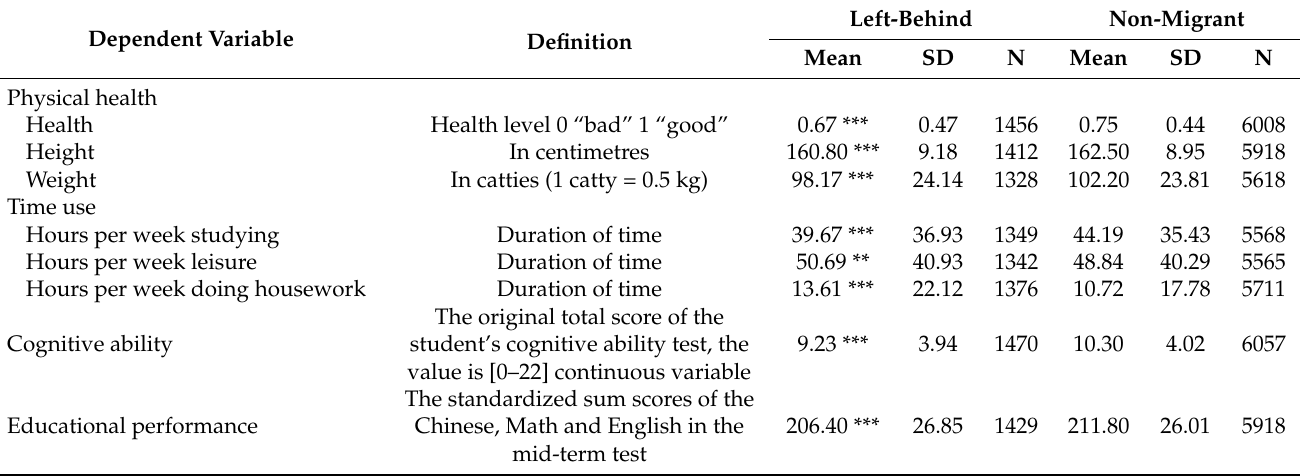
Table 2. Definitions and descriptive statistics of the dependent variables in the analytical sample of urban children (N = 7527): CEPS